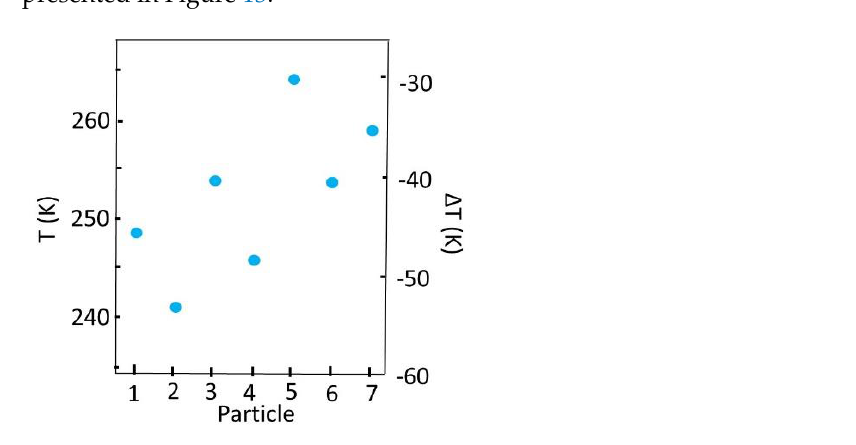
Figure 13. The lowest temperatures of seven nanocrystals (left axis). The decreases in the crystal’s temperature reached by seven nanocrystals (right axis).